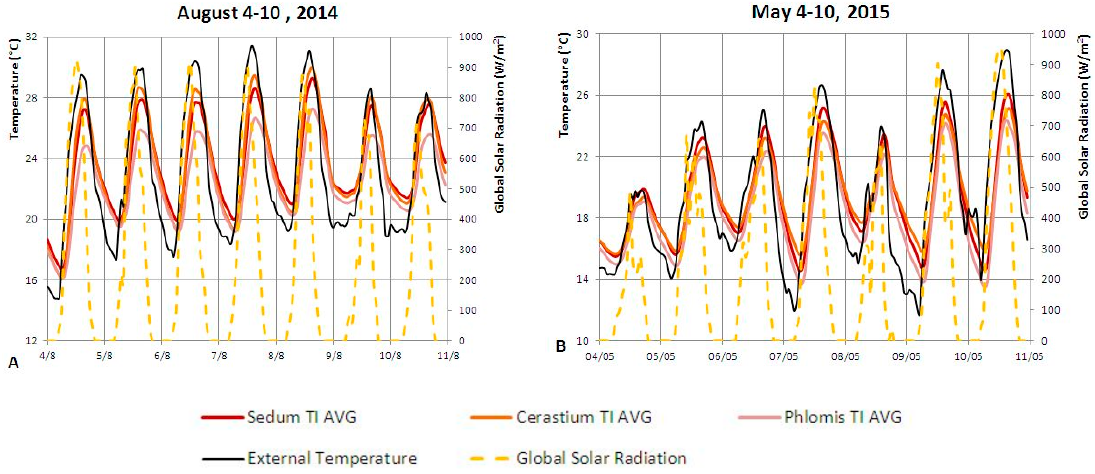
Figure 7. Trend of the inside temperatures of the growing medium (T i ) as a function of the global solar radiation and the external temperature: ( A ) summer 2014; and ( B ) spring 2015.